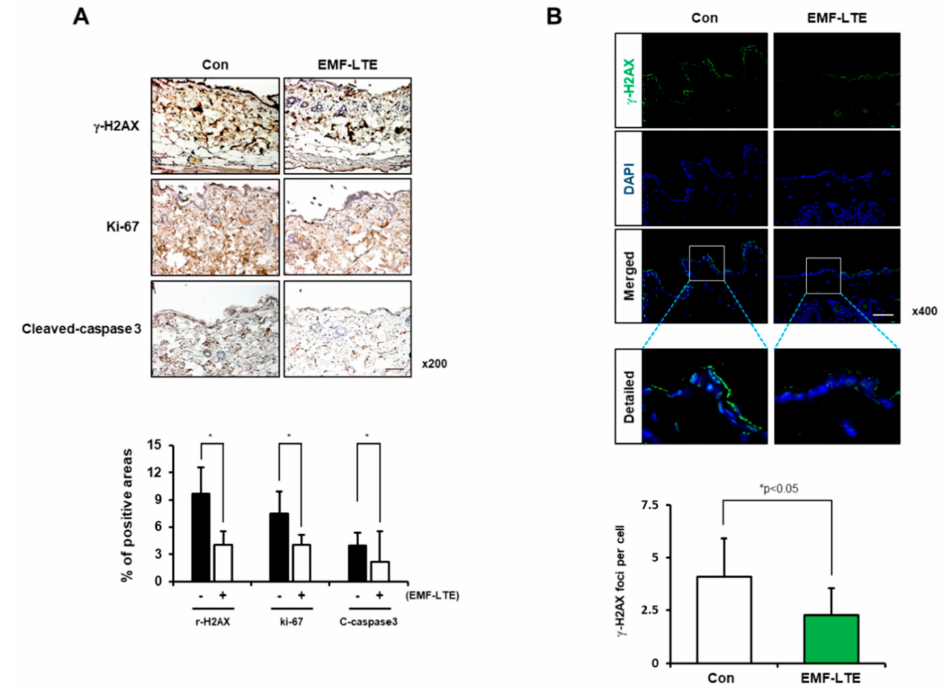
Figure 5. Effects of EMF-LTE on DNA DSB damage markers in mouse skin. ( A ) Immunohistochemistry of mouse skin tissue with antibodies for γ -H2AX, Ki67, and cleaved-caspase 3 was conducted. The percentage of positively stained cells per field is shown. Representative photos are presented. The scale bar indicates 50 µ m (magnification: 200 × ). ( B ) Immunofluorescence staining of mouse skin tissue with anti- γ -H2AX antibody (green) after EMF-LTE. The nuclei were counterstained with DAPI (blue) (upper panel). Representative photos are presented. The scale bar indicates 50 µ m (magnification: 400 × ). The number of γ -H2AX foci for cells in 30 fields was counted, as was the average number of foci per cell. Quantification was performed using Image J software. The data represent the mean ± SD. * p < 0.05 compared with the unexposed control group ( n =